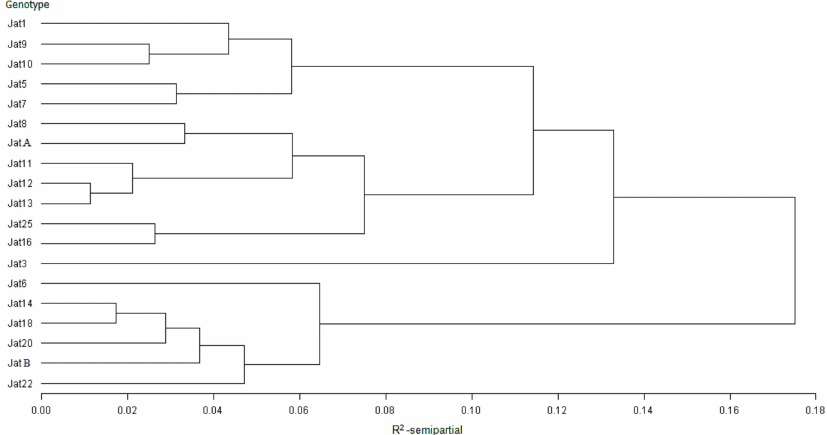
Figure 2. Cluster analysis of 19 genotypes of J. curcas